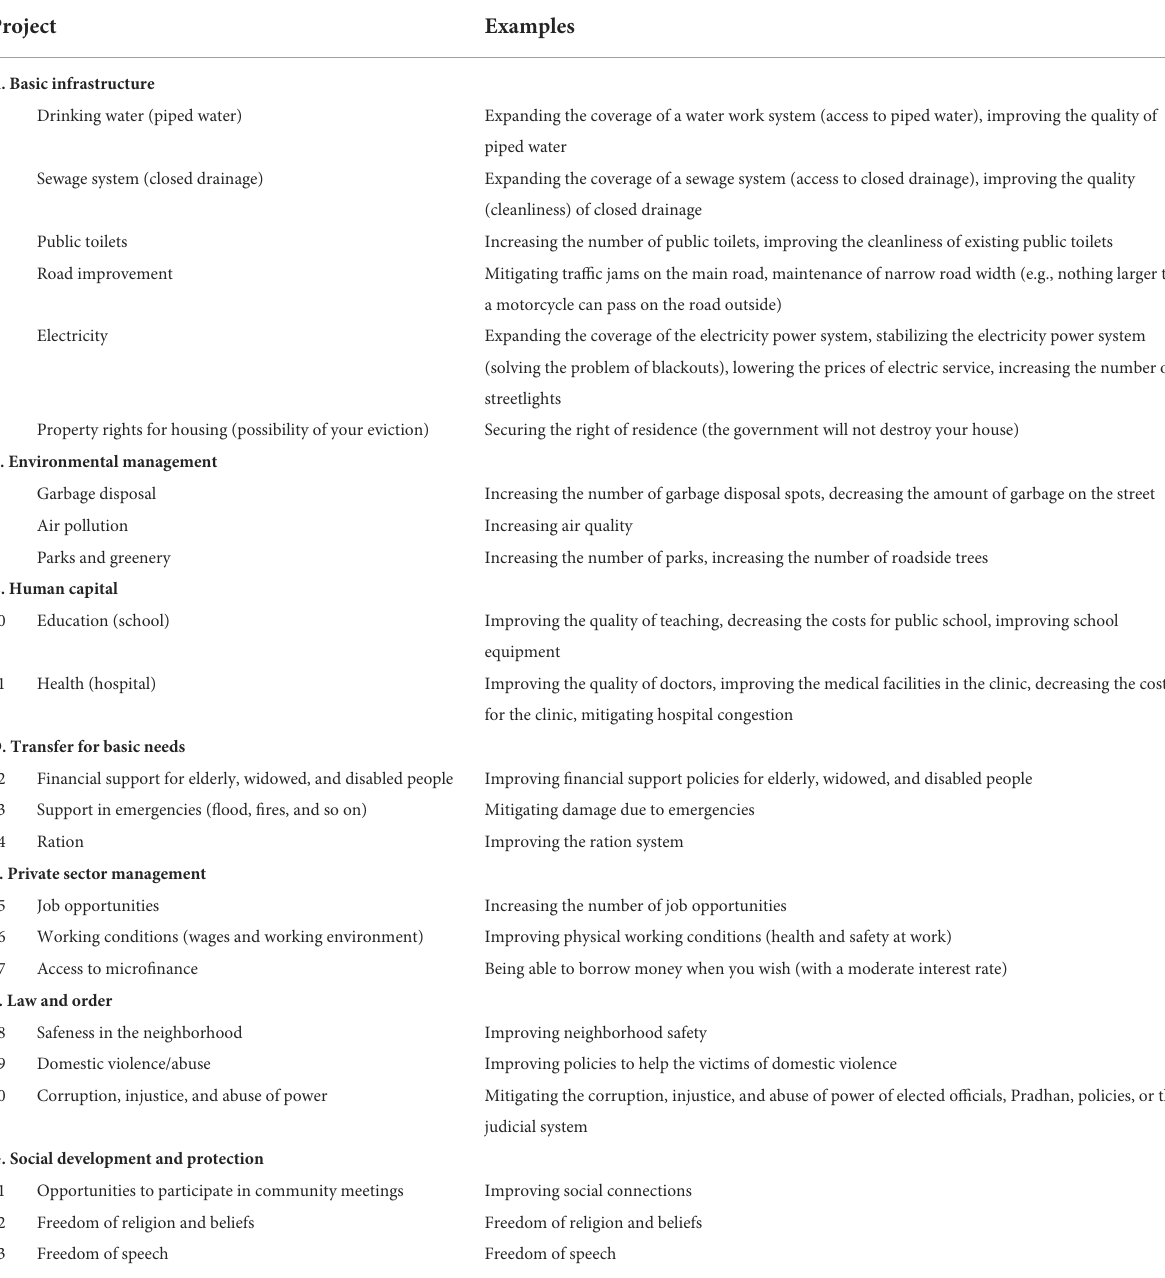
TABLE 1 List of development